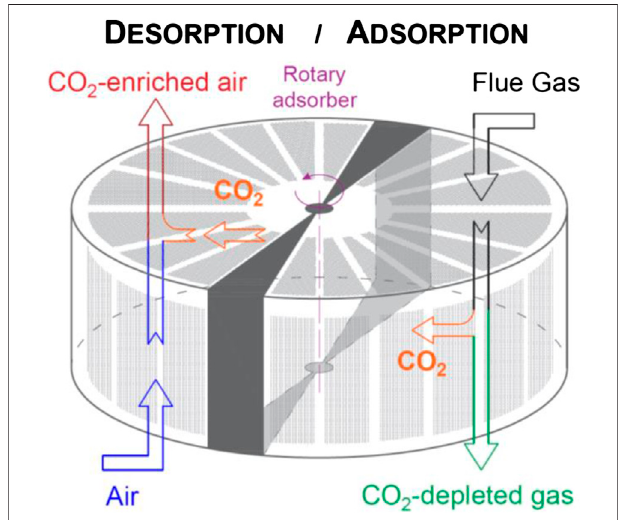
FIGURE 2 | Schematic diagram of a rotary adsorbent for selective CO 2